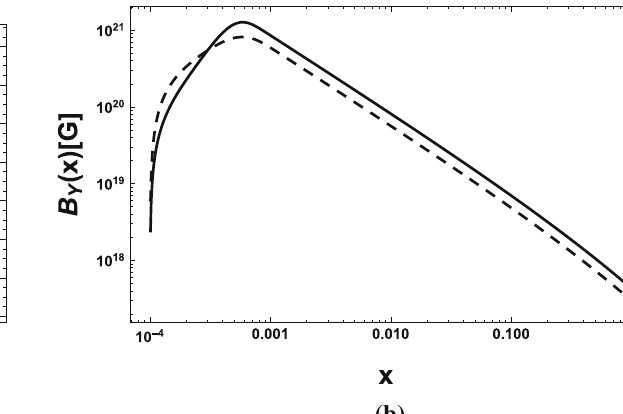
Fig. 4 Time plots of: a the baryon asymmetry η B , and b the hyper- magnetic field amplitude B Y , for two different vorticity configurations. The initial conditions are: k = 10 − 7 , B